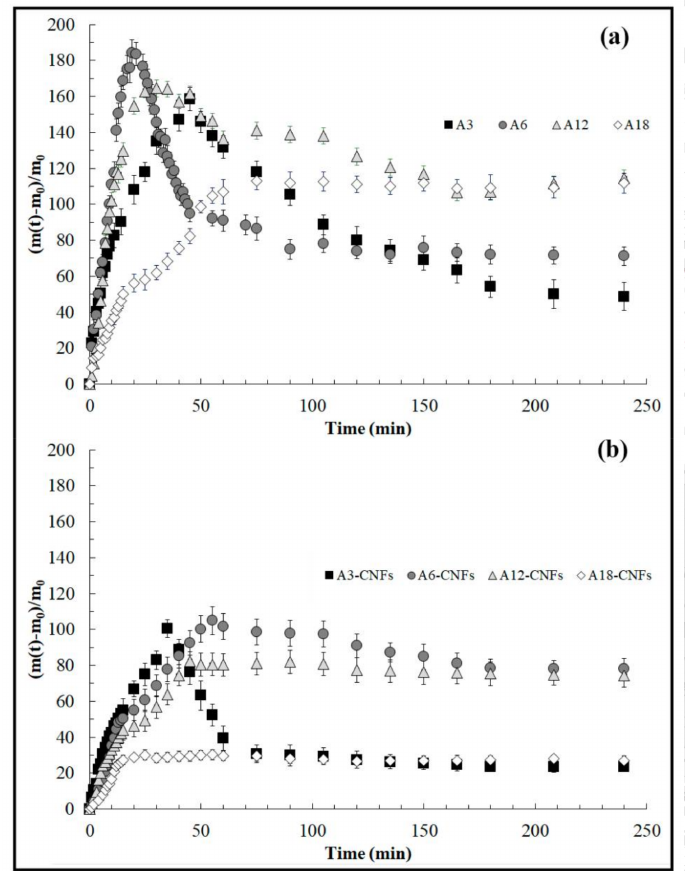
Figure 1. Water contents (grams of absorbed water per grams of dry sample) at 24 ± 0.5 ◦ C represented as mean ± standard deviation for alginate hydrogels synthesised with several calcium chloride contents ( a ) and with also the addition of 0.1% w/w of CNFs ( b